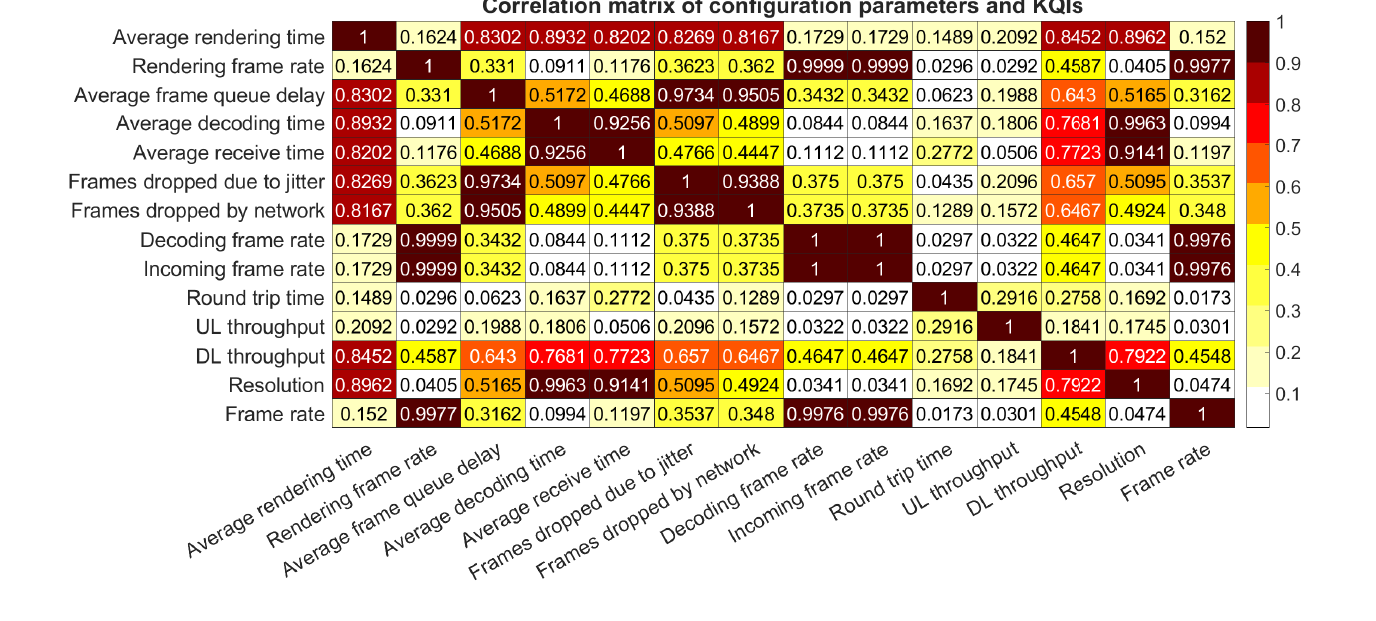
Figure 11. Correlation Matrix of Configuration parameters and